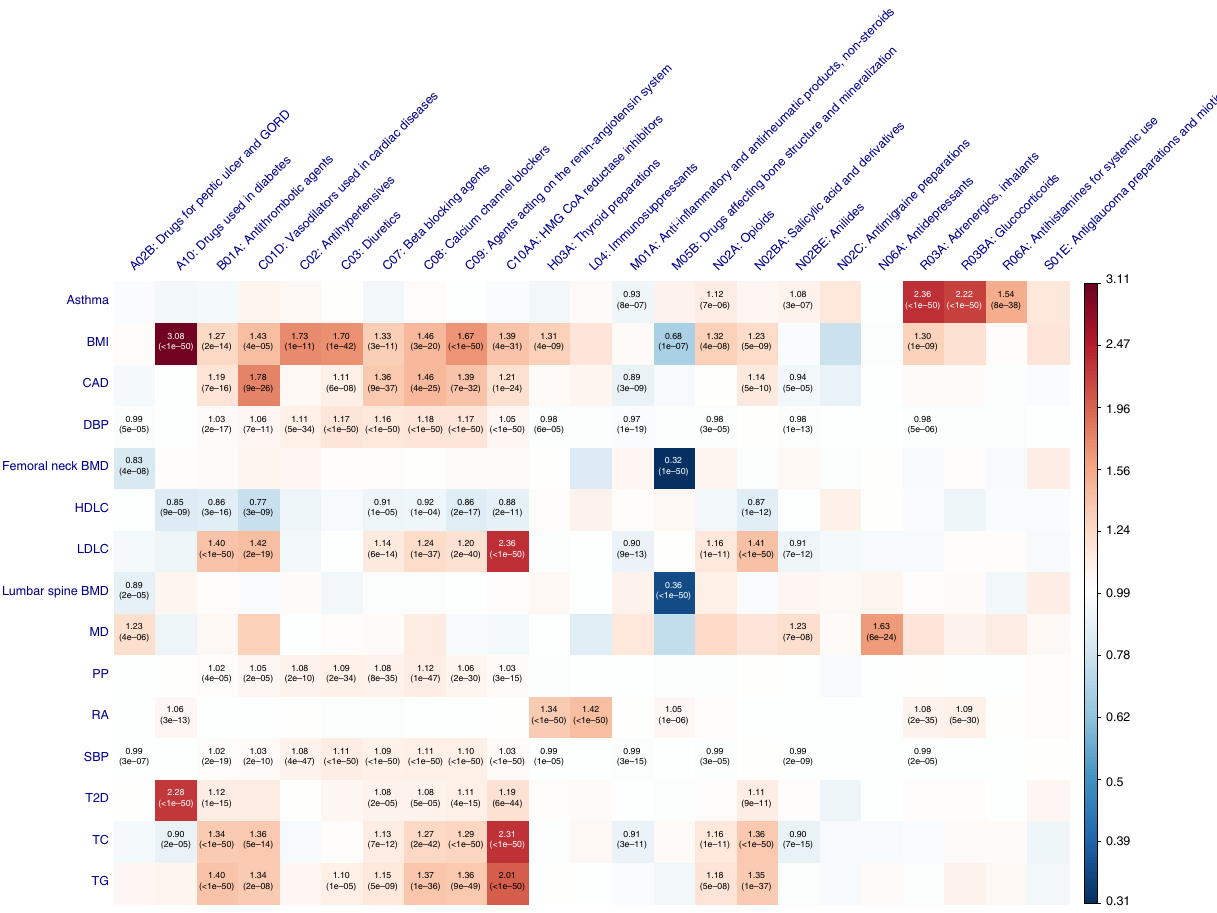
Fig. 5 Mendelian Randomization results between 15 diseases/traits and medications. Rows represent 15 diseases/traits as exposure and columns represent 23 medication-taking traits outcome. The signi fi cant effects after correcting for 345 tests ( P ≤ 1.4 × 10 − 4 ) are labelled with OR ( P value). The OR is per SD in liability when the exposure is disease. Abbreviation: Body mass index (BMI), Coronary artery disease (CAD), Diastolic blood pressure (DBP), Bone mineral density (BMD), High-density lipoprotein cholesterol (HDLC), Low-density lipoprotein cholesterol (LDLC), Major depression (MD), Pulse pressure (PP), Rheumatoid arthritis (RA), Systolic blood pressure (SBP), Type 2 diabetes (T2D), Total cholesterol (TC), Triglyceride